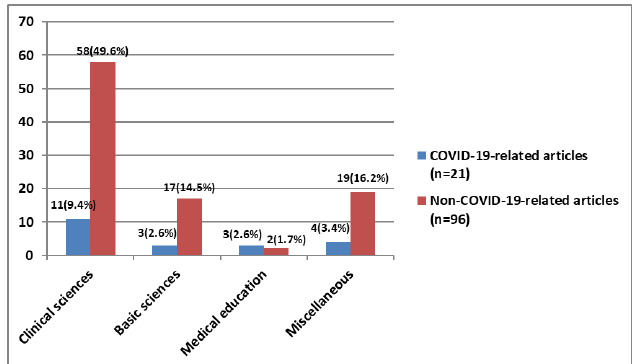
Figure 3 : The covered areas of COVID-19 and non-COVID-19- related articles published in KCMJ between the years 2020 and